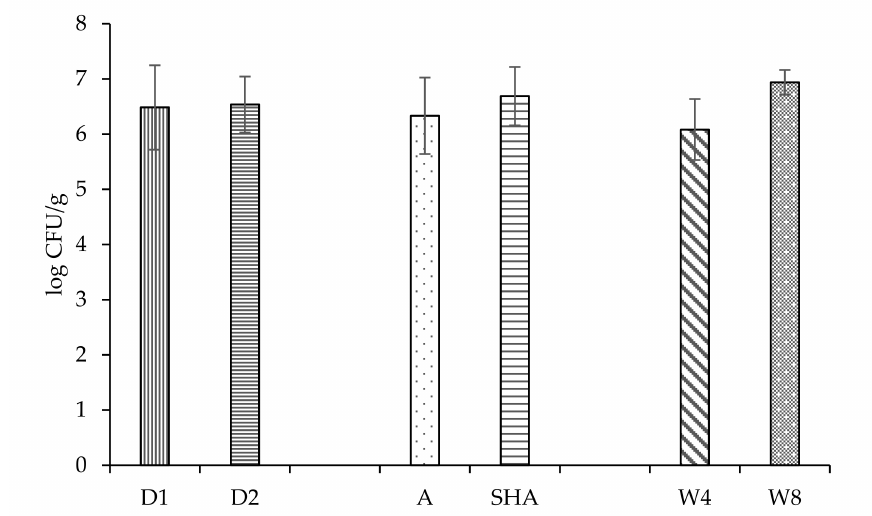
Figure 8. Summary of aerobic bacteria number (log CFU/g) results by treatments (Doses), soil types, and sampling weeks. The codes are as follows: D1: Dose 1. D2: Dose 2. A: Arenosol. SHA: slightly humous Arenosol. W4: Week 4. W8: Week